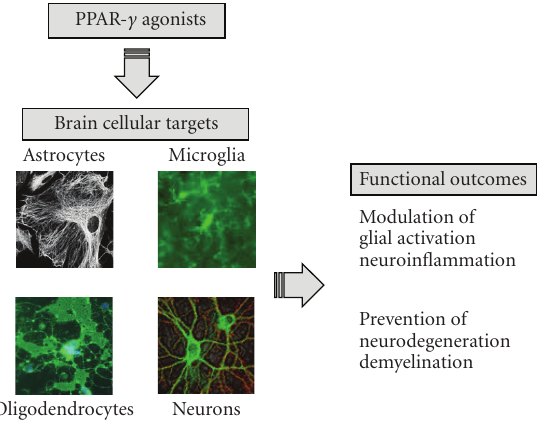
Figure 1: Cellular targets of PPAR- γ agonists in neurodegenerative diseases. PPAR- γ agonists can control neuroinflammation, neu- rodegeneration, and demyelination by e ff ecting several cellular tar- gets and by several direct and indirect mechanisms. PPAR- γ agonists can control glial activation, preventing a number of proinflam- matory activities that can contribute to myelin/OL damage and neurotoxicity PPAR- γ agonists may also a ff ect OLs and neurons, by preventing release inflammatory mediators and/or promote the synthesis of soluble factors or membrane-bound molecules that control glial